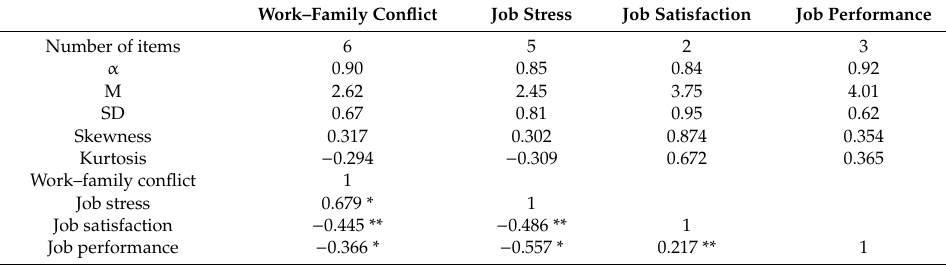
Table 2. Internal consistency, descriptive statistics, and